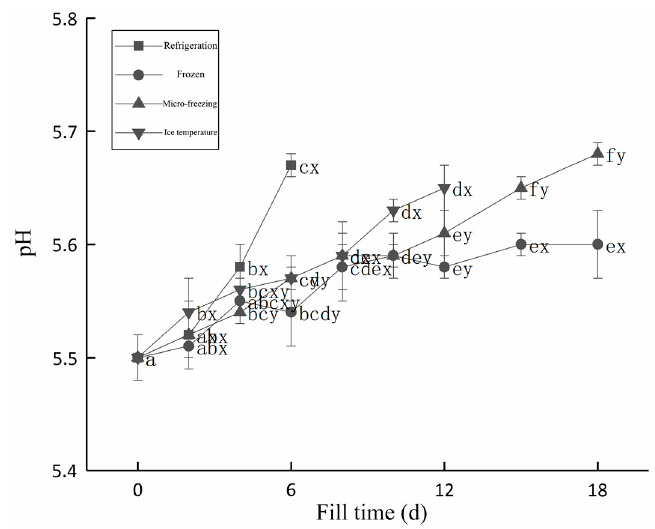
Figure 2. Changes in pH during beef storage with different low-temperature storage methods. d,